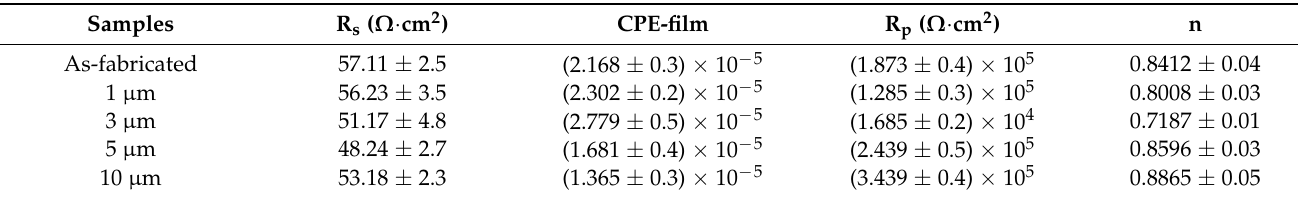
Figure 10. Equivalent circuit used to fit the data. Table 3. Fitting results of the electrochemical parameters from EIS